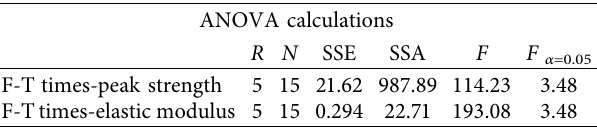
Table 3: Summary of statistical analysis. ANOVA